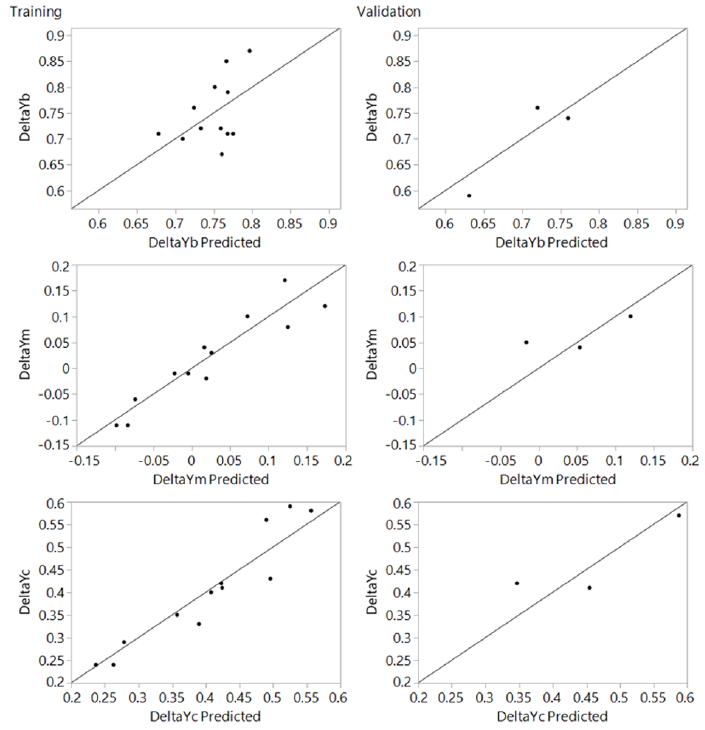
Figure 13. Actual by predicted plot for training and validation for the mesh size of 3 × 3 mm.